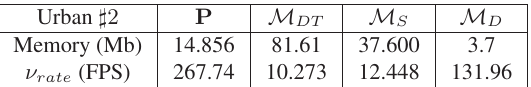
Table 3: Memory usage and frame frequency measures